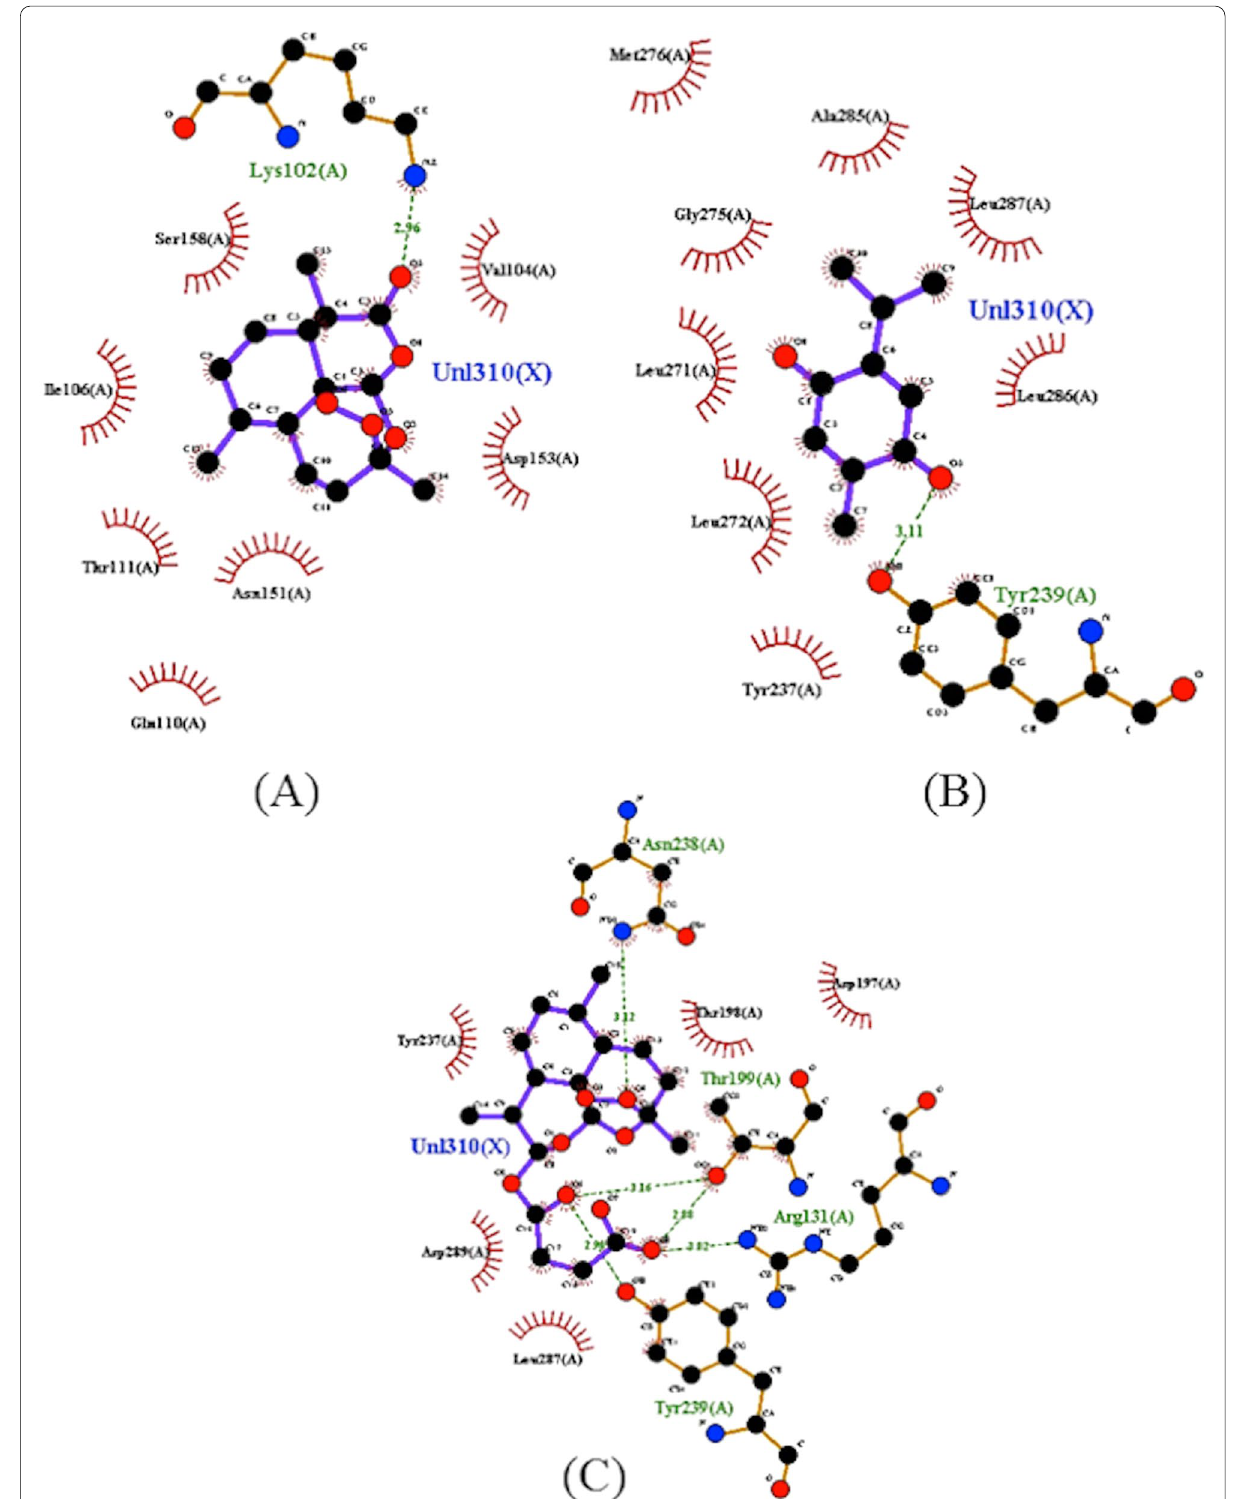
Fig. 6 2D map representative of H-bonds between parental ligands and Mpro SARS-CoV-2. A Artemisinin, B artesunic acid, C